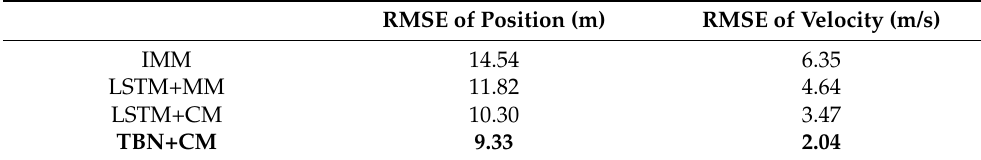
Table 3. Numerical results of several methods for tracking trajectory